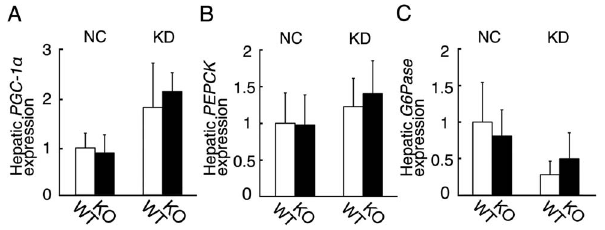
Figure 8. Hepatic expression of key genes involved in gluconeogenesis in wild-type and Fgf21 knockout mice fed NC or KD. Hepatic expression of PGC-1 a , PEPCK , and G6Pase in wild- type (WT) and Fgf21 knockout (KO) mice fed NC or KD for 6 days. (n=6– 8 mice per group).